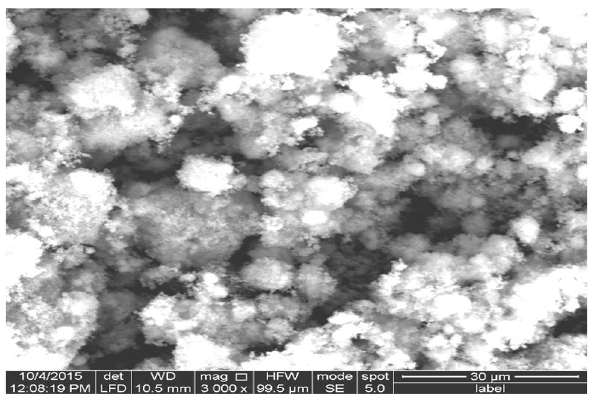
Figure 1. Transmission Electron Microscope (TEM) image of